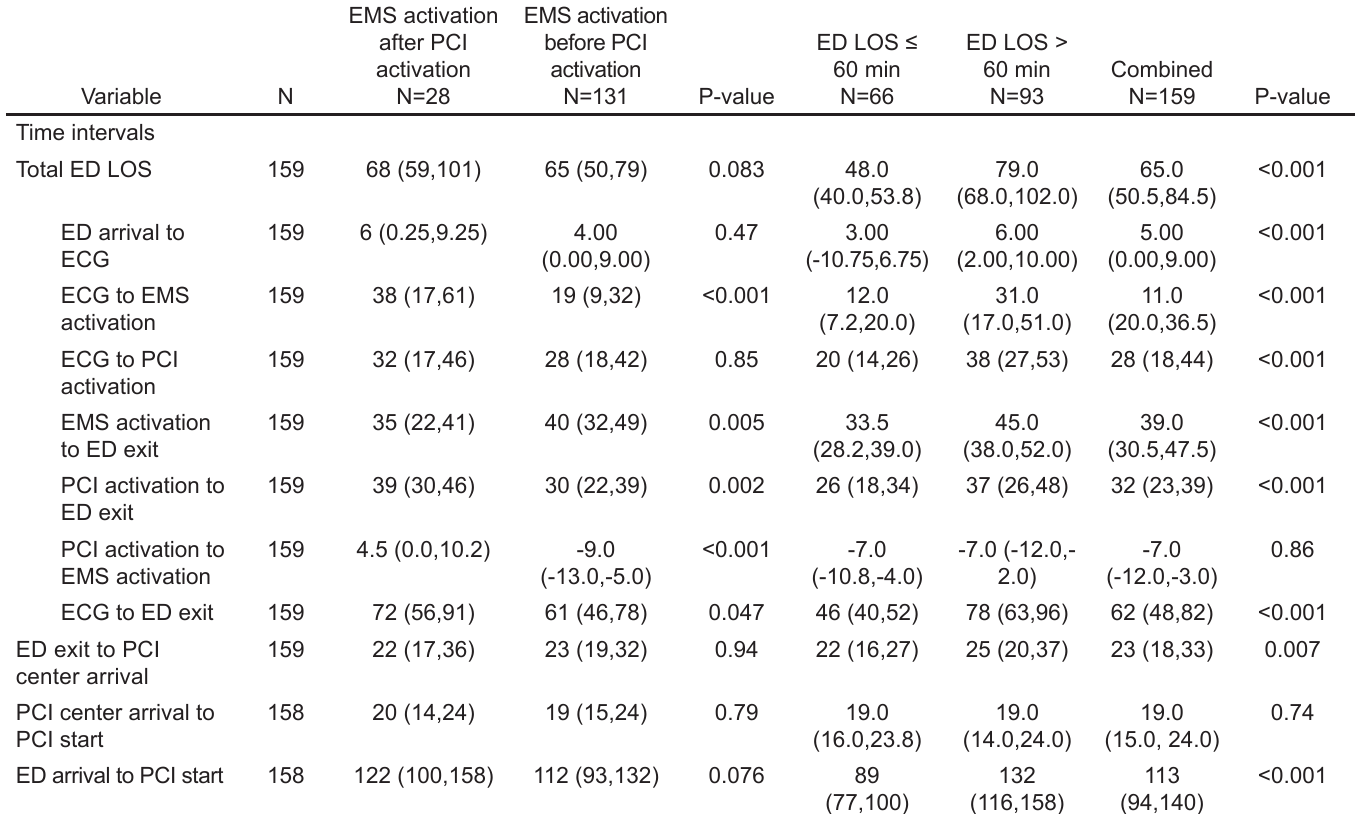
Table 2. Descriptive statistics of percutaneous coronary intervention activation timing relative to emergency medical services activation, and for those transfers above and below 60 minutes by time